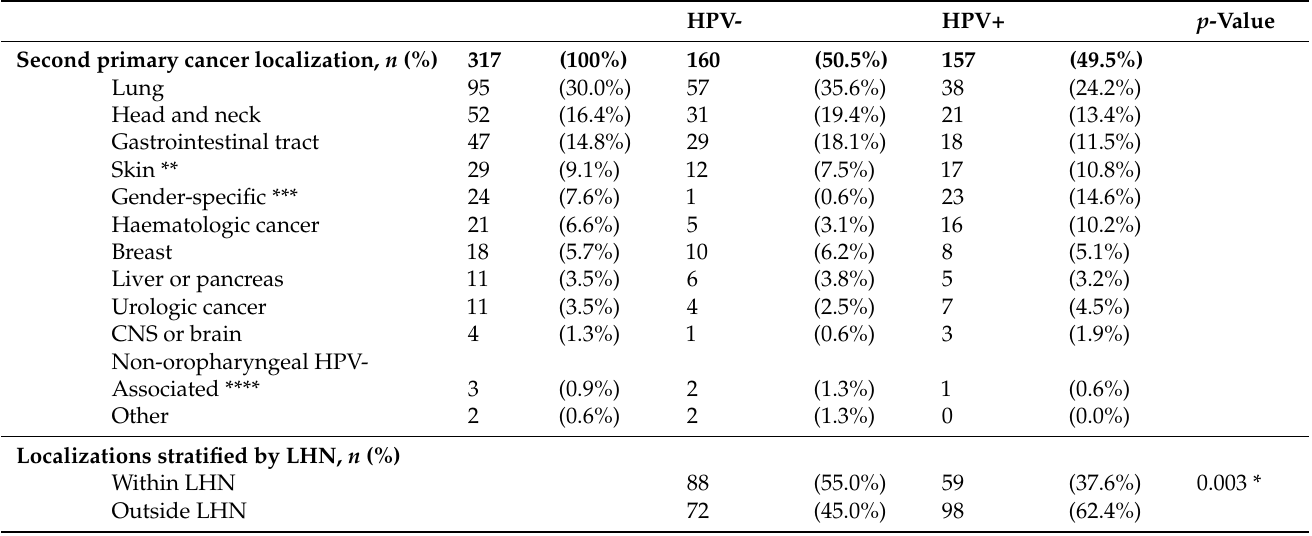
Table 3. Localizations of SPC following OPSCC in eastern Denmark, overall and stratified by HPV status. HPV- HPV+ p